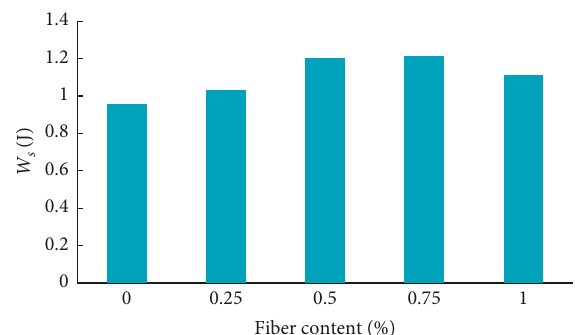
Figure 22: Energy dissipation W